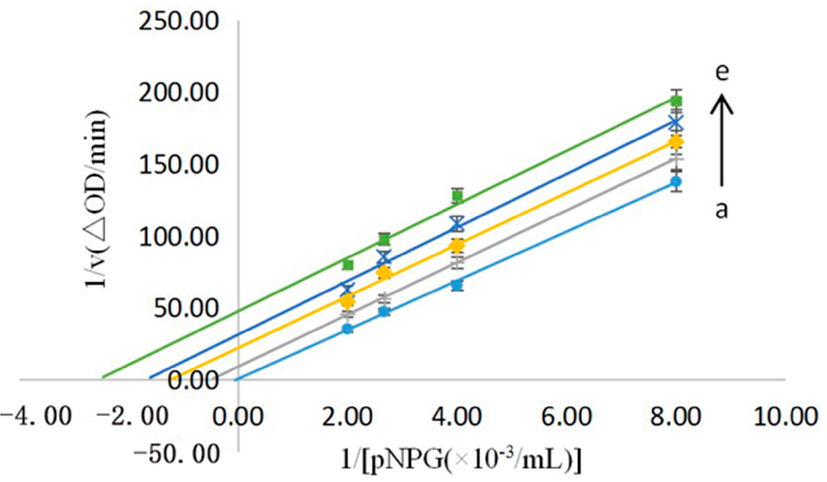
Figure 7. The enzyme kinetics of the reversibility of the No.9 Sample on the α− glucosidase [C(No.9) = 0.06, 0.08, 0.10, 0.12, and 0.14 mg/mL for the curves a → e,